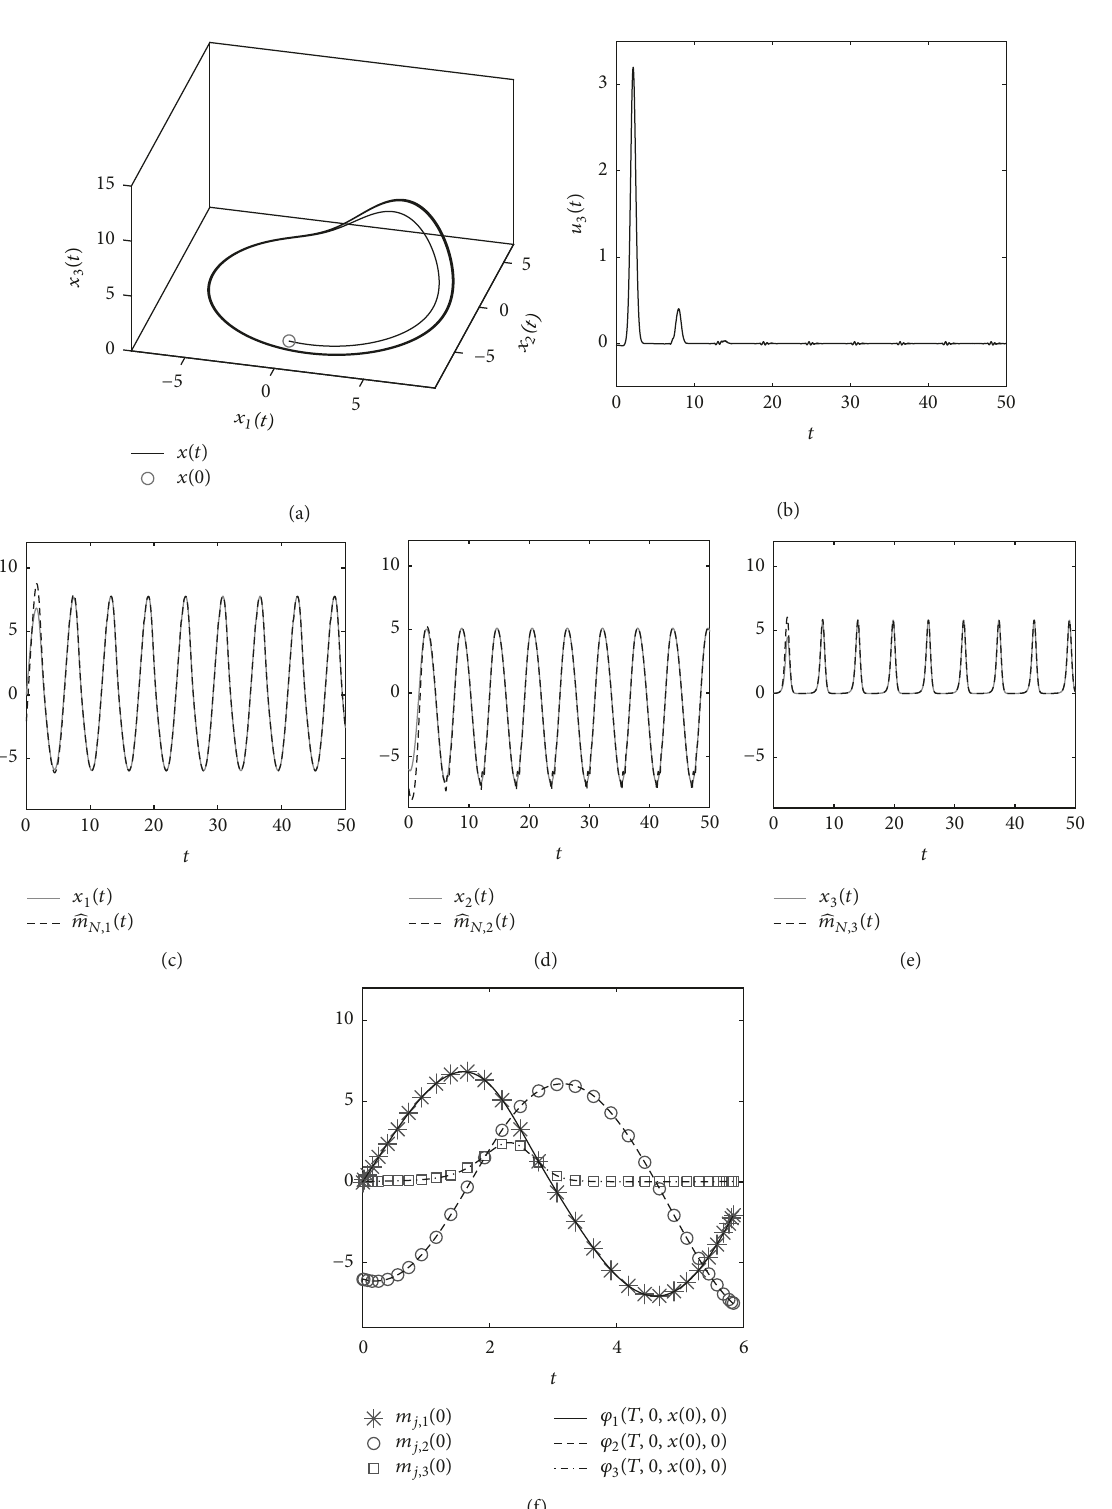
Figure 24: aPBC applied to the R¨ossler system with 𝑁 = 32 , 𝑘 = 1.85 , and 𝑘 𝑜 = 10 . (a) Trajectory in state space; (b) time-series of the control signal; ((c), (d), and (e)) time-series of the actual and predicted state variables; (f) time-series of 𝜑(𝑇,0,𝑥(0),0) and the initial value of the predicted states 𝑚 𝑗 (0)